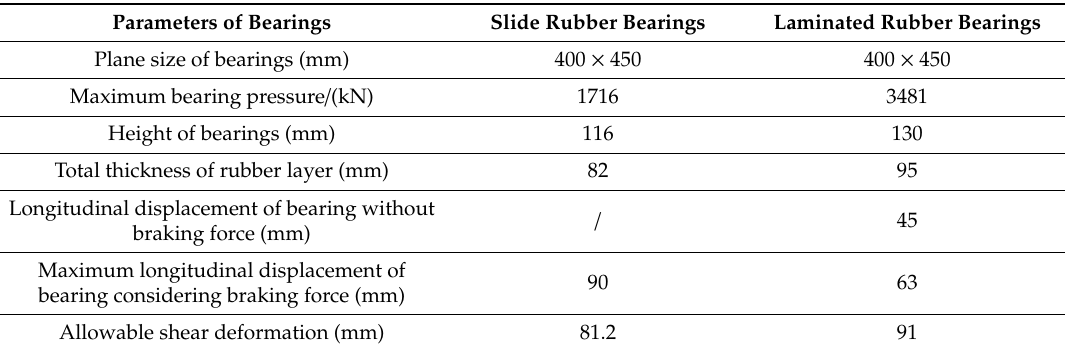
Table 1. Design parameters of bearings.